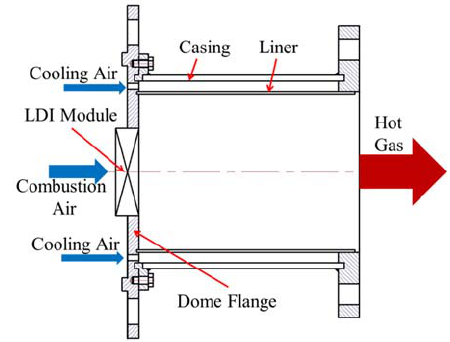
Figure 11. The LDI single tube combustor.